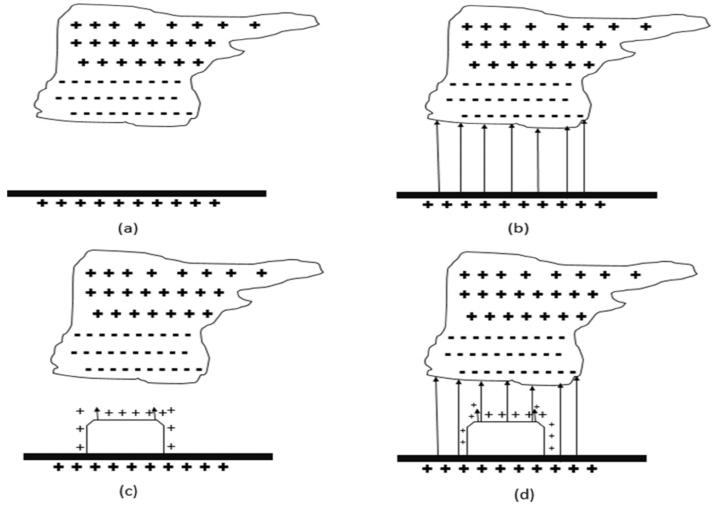
Figure 2. Electrification of grounded building structures with installed LAT during a thunderstorm; ( a ) matured cumulonimbus cloud, ( b ) cloud-to-ground electric field concentration, ( c ) mirror-image positive charges due to cloud base negative charges; the grounded structure is covered with positive charges, ( d ) electric field lines linking the ground and building with electric fields connected to the cloud.